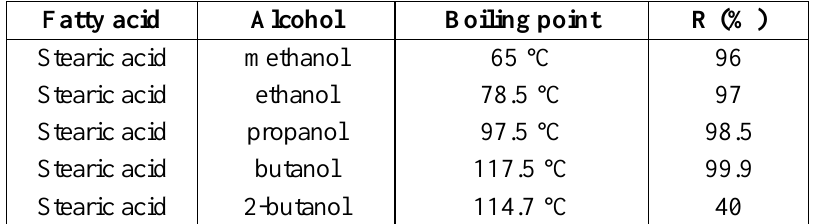
Table 2. Esterification yields of stearic acid with different alcohols over KSF/0 catalyst (0.1 w/w) at 150